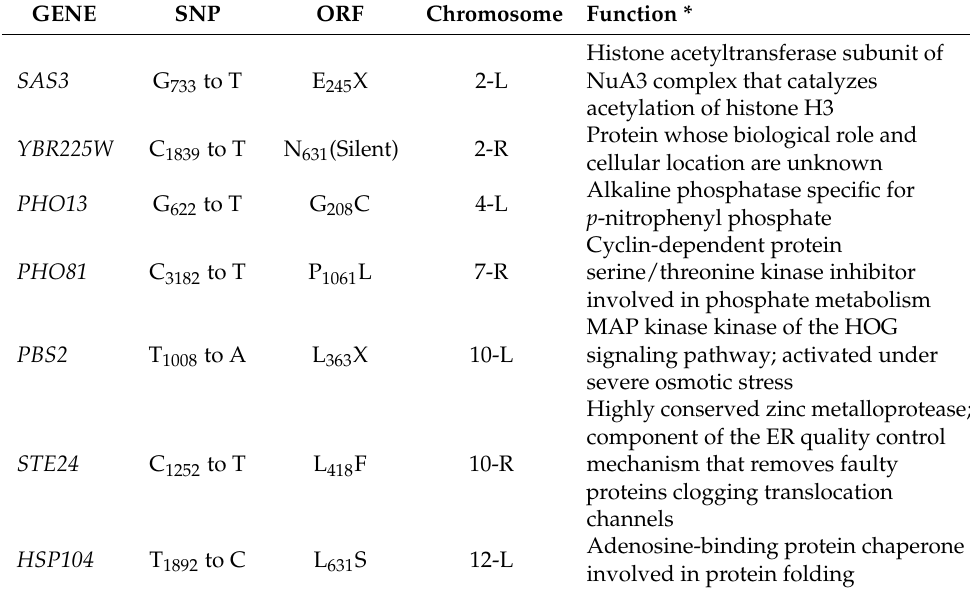
Table 3. SNPs identified in the adapted YRH1114